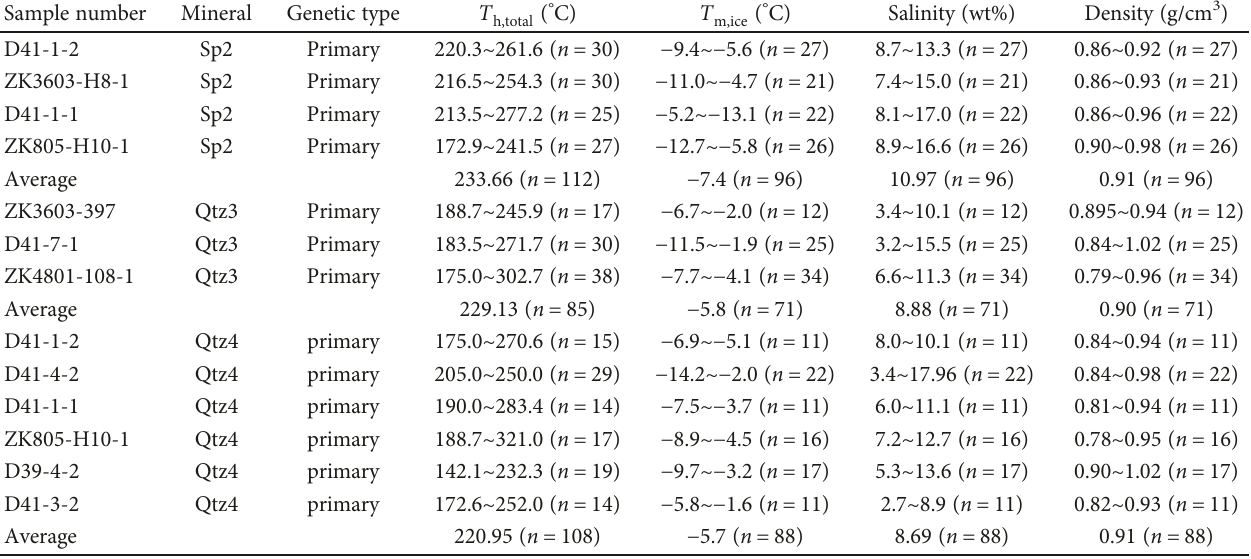
Table 2: Microthermometric results of fl uid inclusions from minerals in the Keyue deposit. Sample